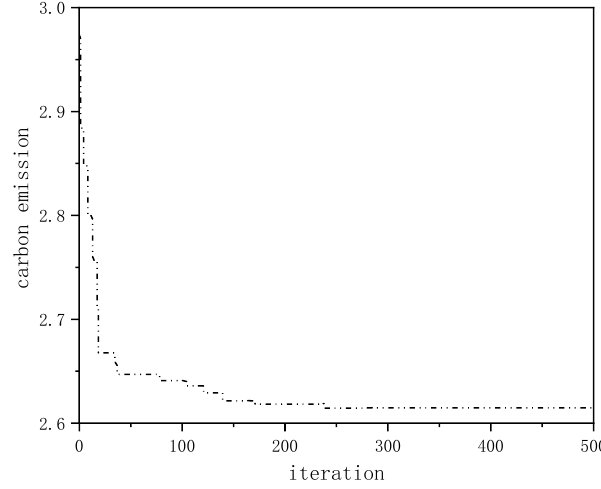
Figure 8. Carbon emission convergence algebraic diagram.